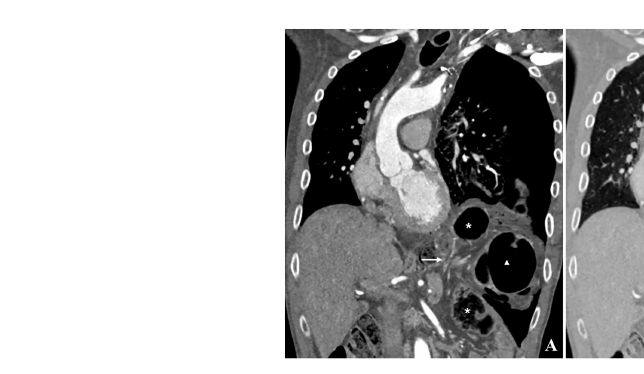
FIGURE 2 (A, B) CT image in coronal reconstruction. A diaphragmatic defect with twisted colon and mesocolon entering and exiting the left hemithorax can be seen. Due to twisting of the colon at the level of the diaphragmatic defect (Arrow) with subsequent closed-loop obstruction, the herniated intrathoracic colon loops are dilated (Star and Triangle). Arrow, Diaphragmatic defect; Star, Aboral part of the transverse colon; Triangle, Oral part of the transverse colon.